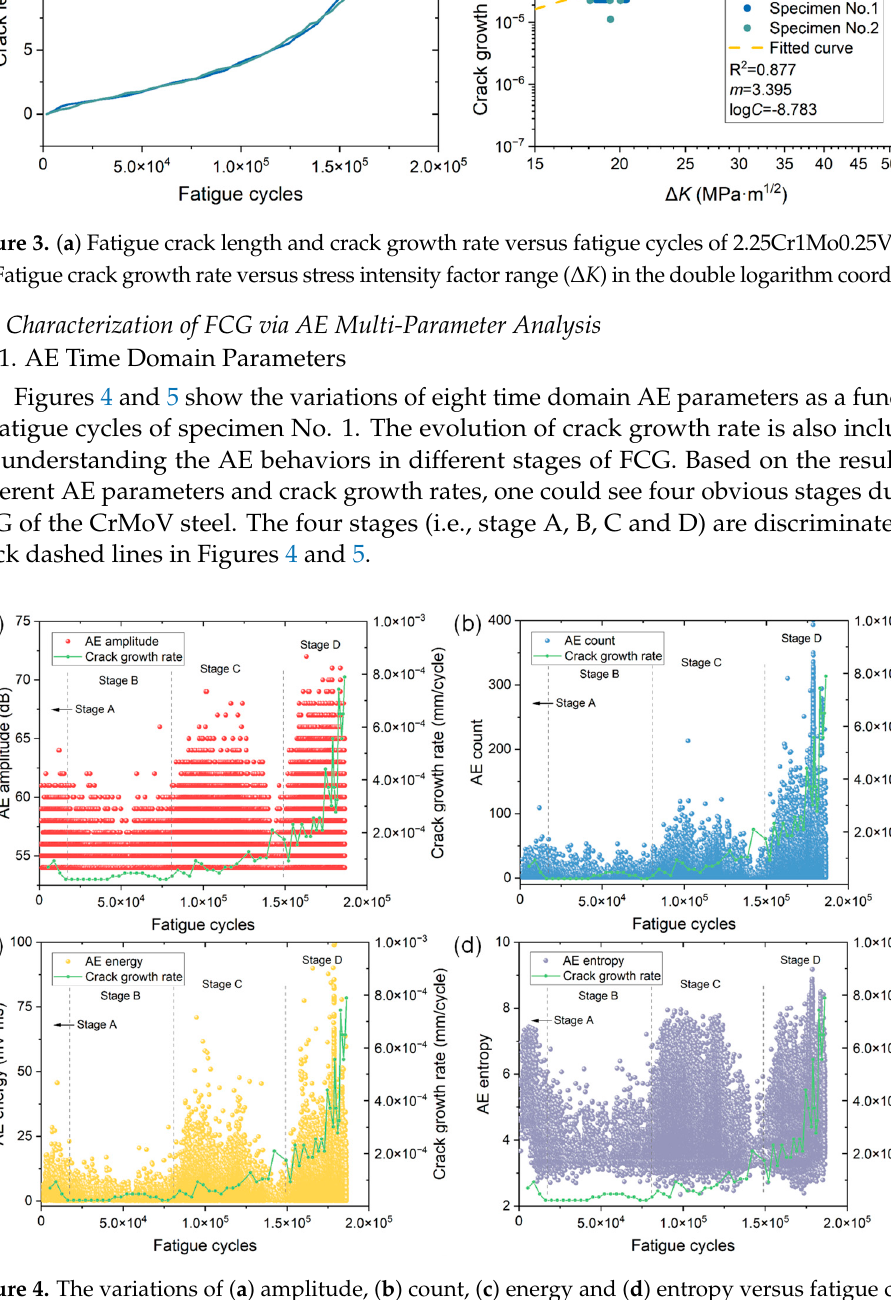
Figure 5. The variations of ( a ) RA value, ( b ) RMS, ( c ) kurtosis and ( d ) crest factor versus fatigue cycles of specimen No.1. The change in crack growth rate is also included for understanding the AE behaviors in different stages. When the crack propagates into stage B, however, the crack growth rate slightly de- creases and remains low. The crack grows almost linearly and the crack size at the end of stage B is less than 2.7 mm, indicating this stage is related to stable crack growth with a low / da dN . In comparison with AE characteristics in stage A, one could see a decrease